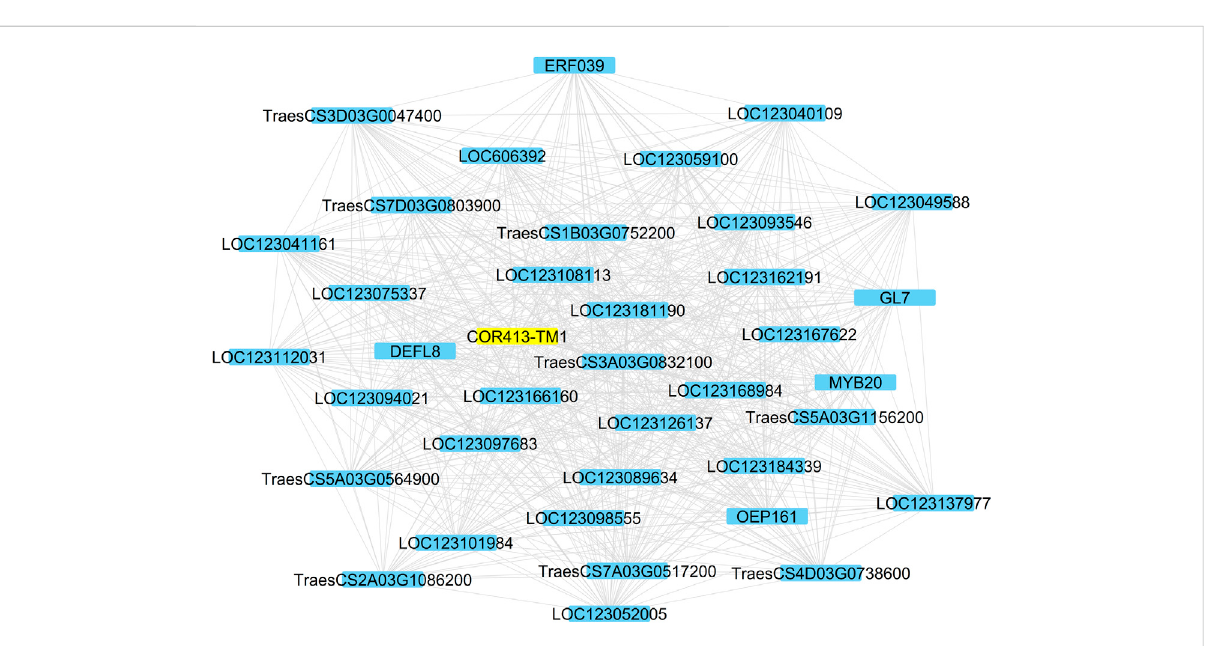
Supplementary File